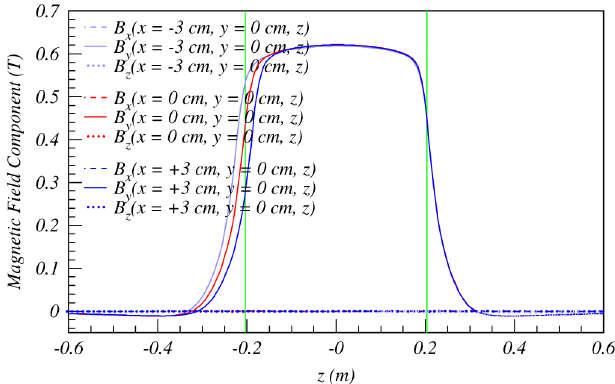
FIG. 14. B x (dashed lines), B y (solid lines), and B z (dotted lines) components of the solid-target analyzing magnet calcu- lated by OPERA-3D/TOSCA [21]. Three different trajectory are shown: inner ( x ¼ (cid:1) 3 cm , y ¼ 0 cm , light blue), center line ( x ¼ 0 cm , y ¼ 0 cm , red), and outer ( x ¼ (cid:1) 3 cm , y ¼ 0 cm , blue). The B x and B z values are very close to zero, and therefore overlap with each other. The vertical green lines represent the magnet pole-face to pole-face extension along the center-line